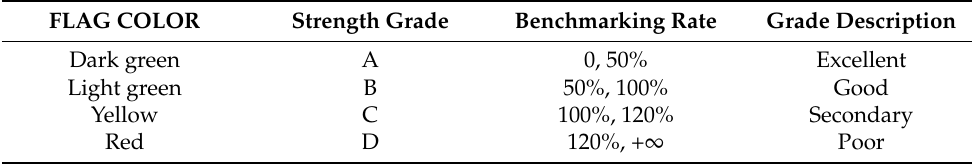
Table 1. Classification of carbon emissions intensity per unit output.